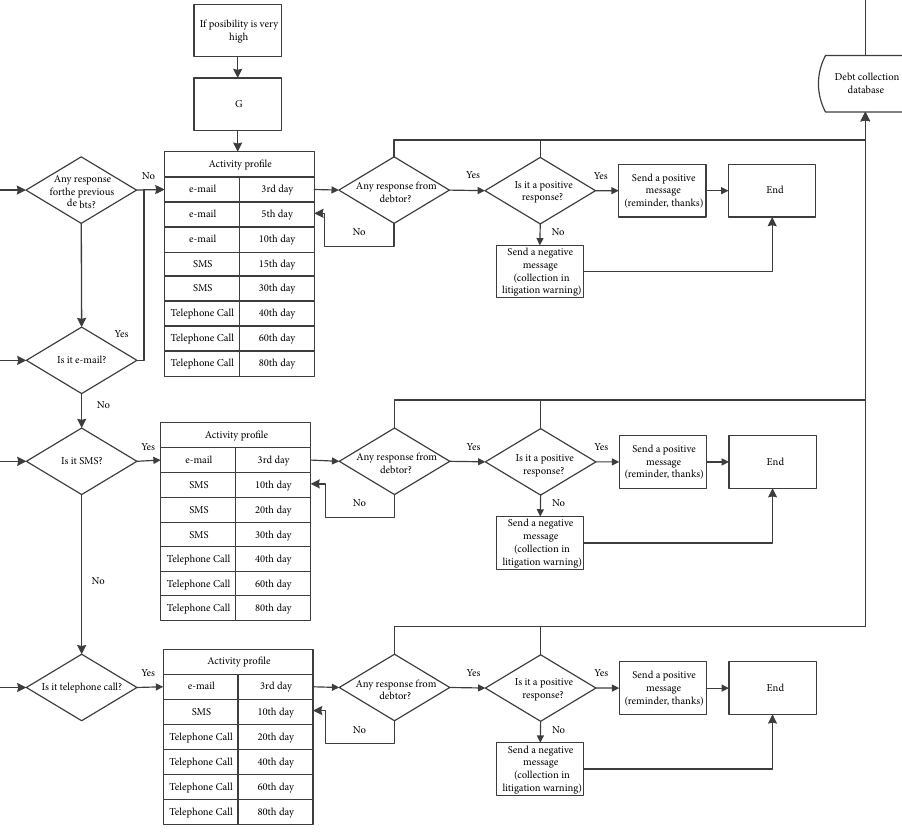
Figure 8. Flow chart Part G- very high possibility Table 1. Triangular membership values for credit card and invoice debts Amount of loan